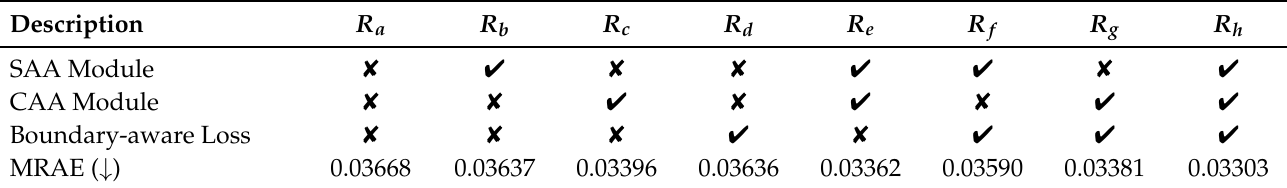
Table 2. Ablation study on the final validation set of NTIRE2020 “Clean” track dataset. We record the best MRAE values in 5.76 × 10 5